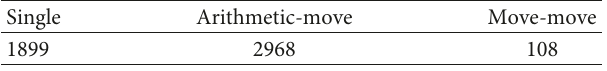
Table 5: Distribution of Belasigna 300 Speex